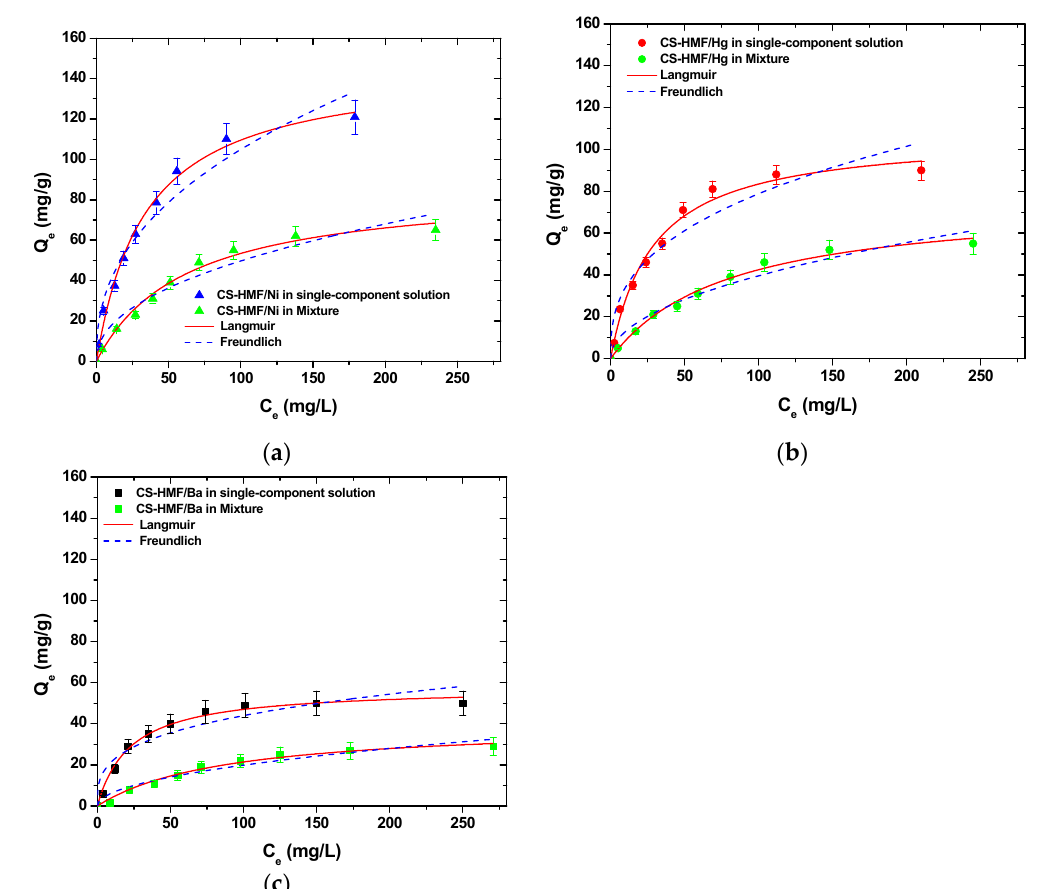
Figure 8. Equilibrium data for the uptake of ( a ) Ni 2+ ; ( b ) Hg 2+ ; ( c ) Ba 2+ from single- and multi-component aqueous solutions, fitting to the equations of Langmuir and Freundlich. Testing conditions: T = 25 °C, C 0 = 10.0–300.0 (mg/L), N = 160 rpm, V = 20.0 mL, t = 200 min, m = 0.02 g, pH = 6.